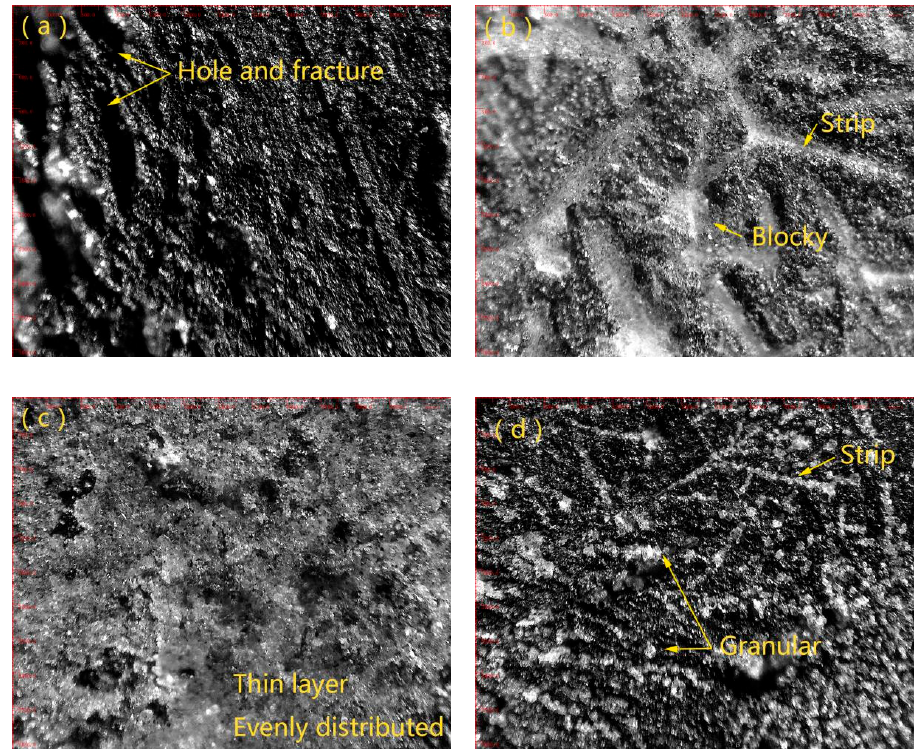
Figure 7. The microscopic photos of sample surface soaked by different drilling fluids: ( a ) water, ( b ) basic fluid + 0.10% TX-10, ( c ) basic fluid + 0.10%HSB1618 and ( d ) basic fluid + 0.10 penetrant T.